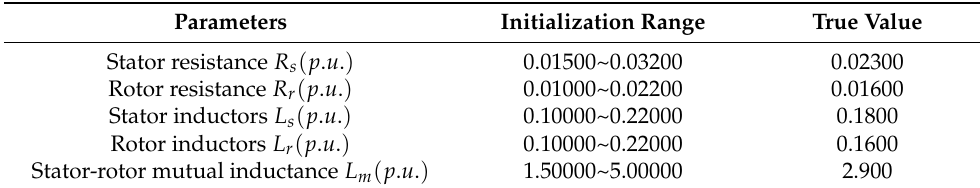
Table 4. True values of motor parameters and their initialization range.